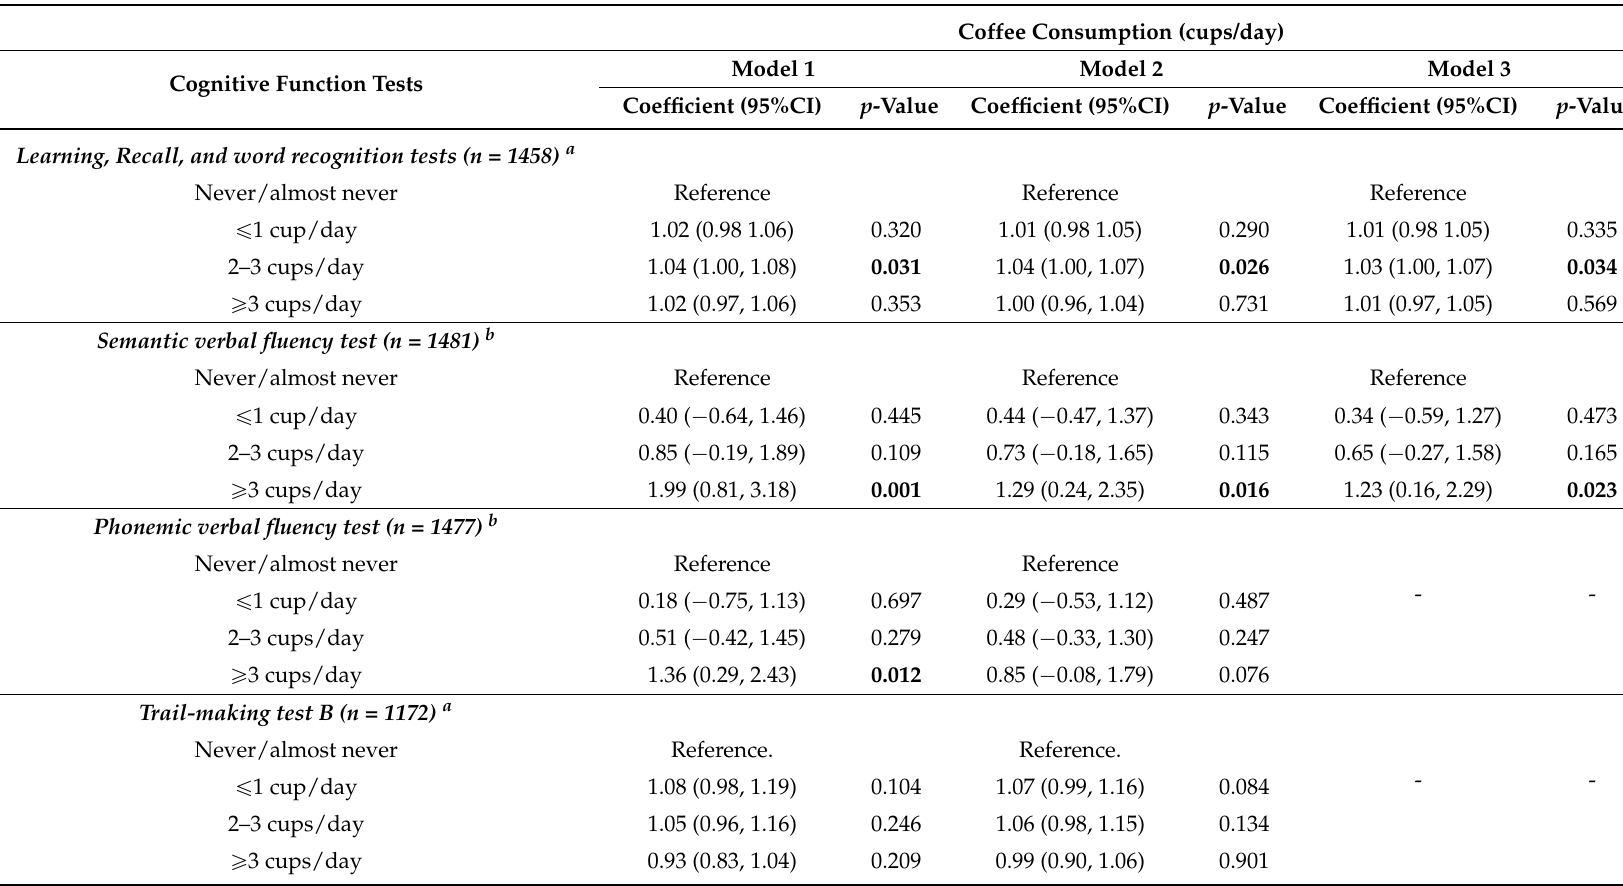
Table 4. Associations between coffee consumption and learning, recall, and word recognition tests, phonemic verbal fluency tests, and trail-making test B among the participants (65 to 74 years of age) of ELSA-Brasil (2008–2010).